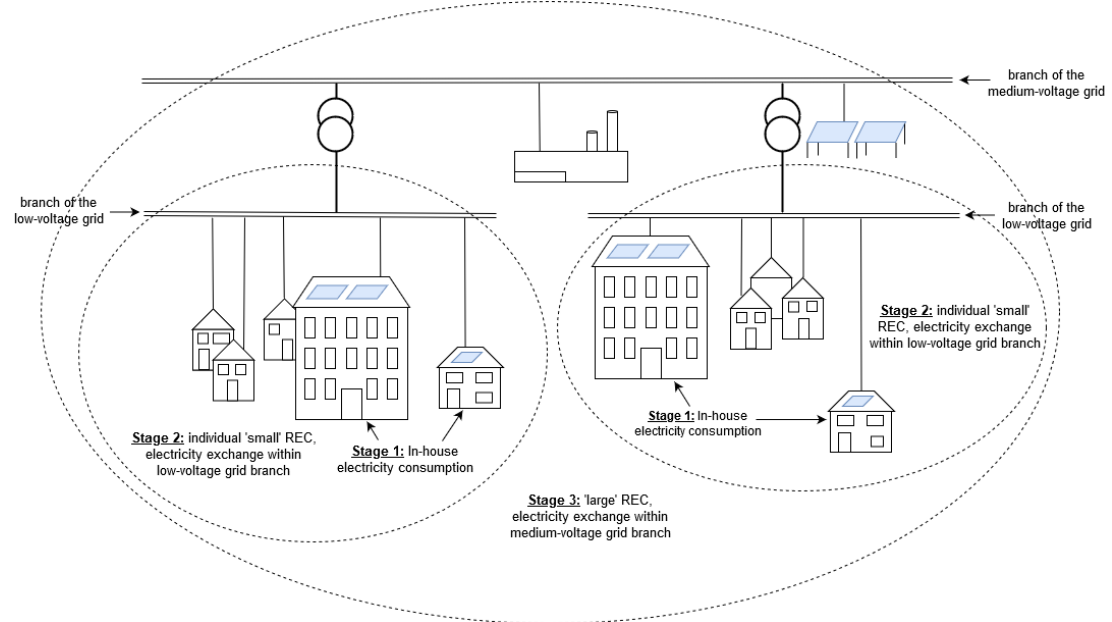
Figure 1. Different levels of a